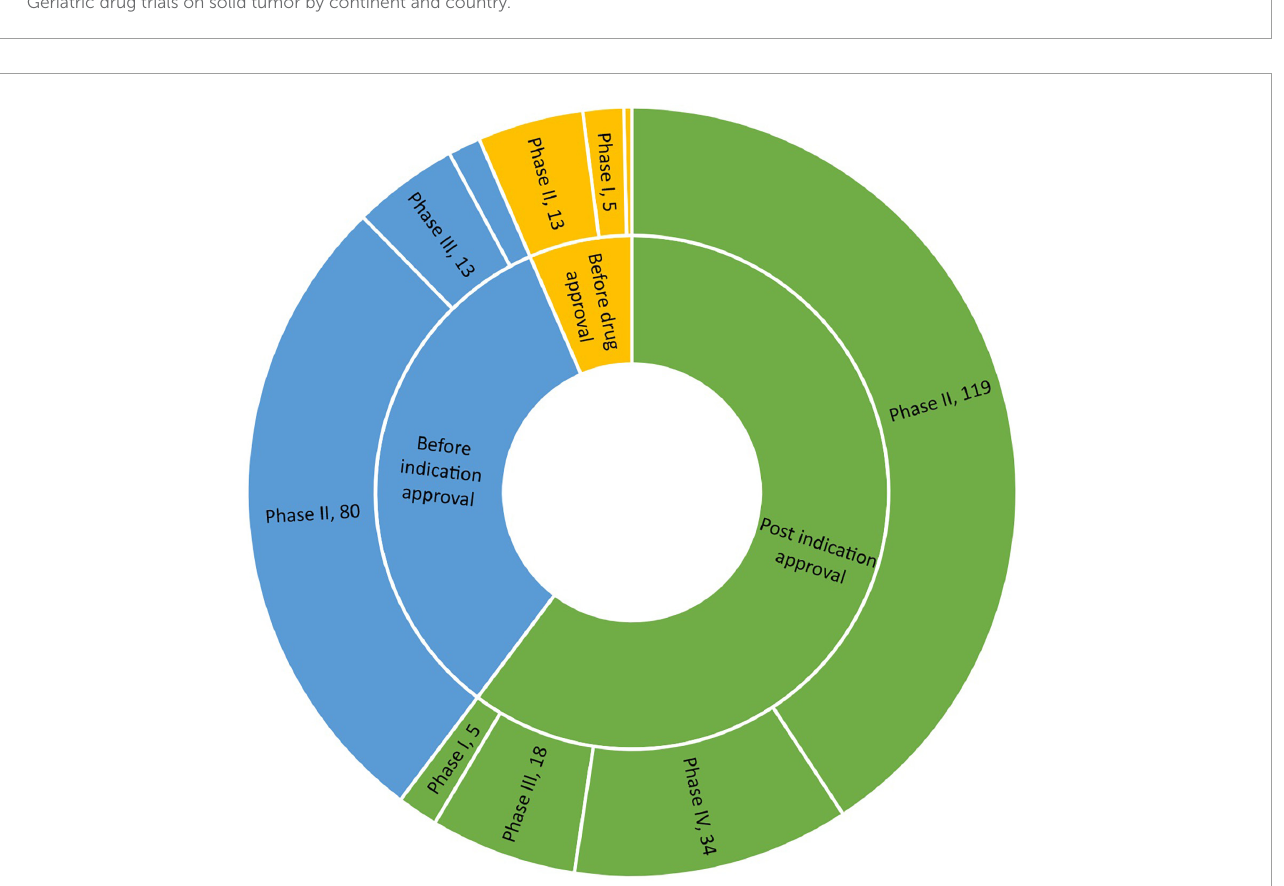
FIGURE3 Development timing and study phase of initiated geriatric drug trials on solid